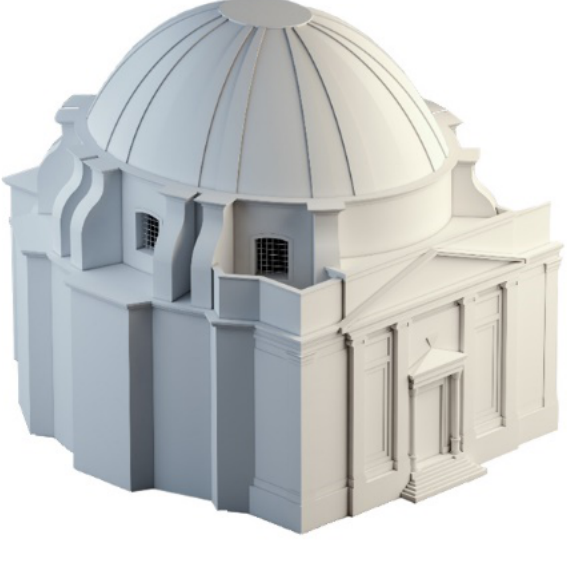
Figure 7. 3D model of San Carlo